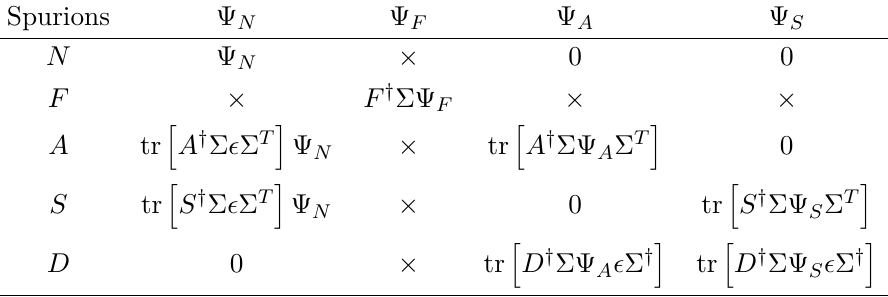
Table 2 . Formally G invariant operators at leading order giving rise to PC of the SM